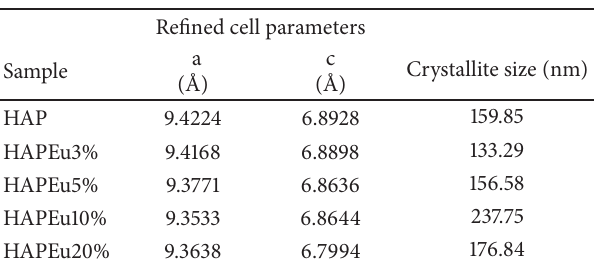
Table 2: Rietveld analysis